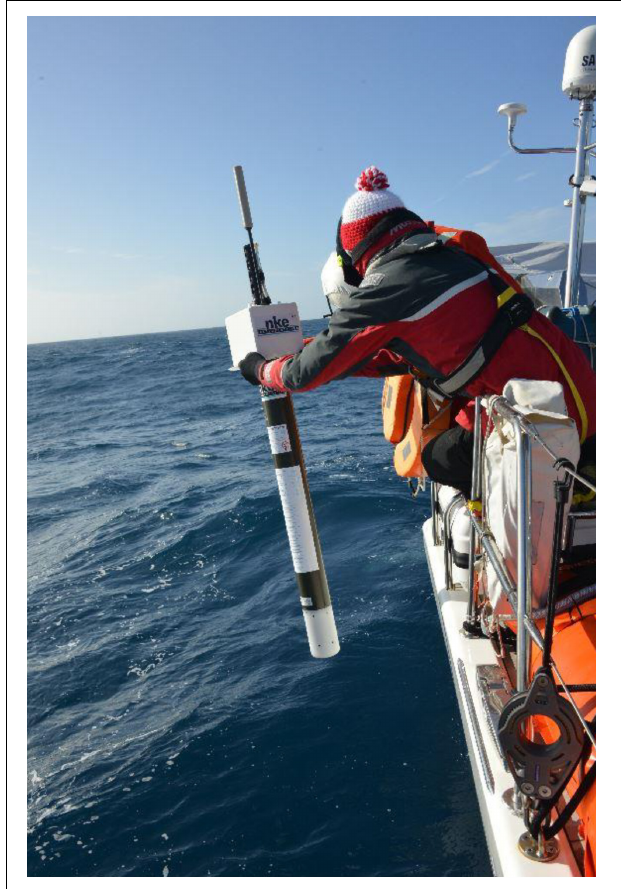
FIGURE 10 | Deployment of an Arvor profiling float in Antarctica, 2018 (courtesy of Hanna